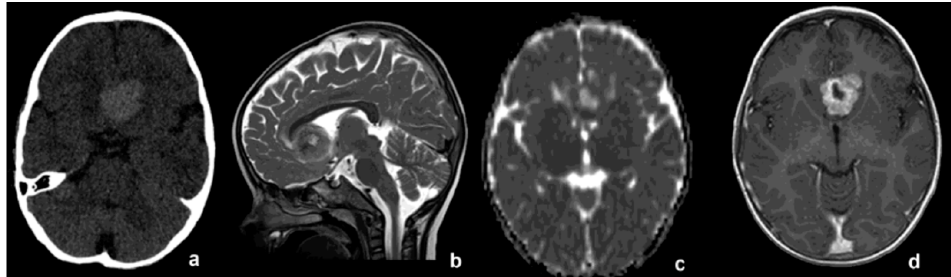
Figure 1. ( a ) CT without contrast medium, showing midline spontaneous hyperdense lesion. ( b ) T2-wi, ( c ) ADC map and ( d ) T1-wi after contrast medium. Pre-operative MRI showing close adhesion to anterior cerebral arteries.